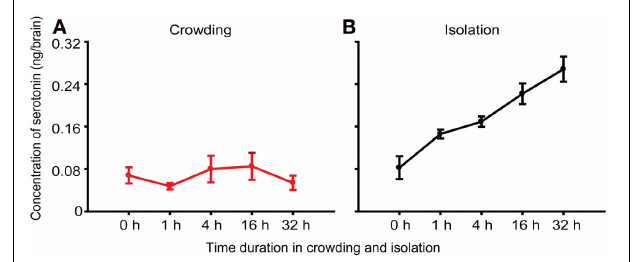
FIGURE 1 | Concentration of serotonin in brains of the migratory locust. (A) Concentration of serotonin in the brains of solitary nymphs subjected to crowding [One-way ANOVA, F ( 4 , 35 ) = 0 . 529, P = 0 . 753]. (B) Concentration of serotonin in the brains of gregarious nymphs subjected to isolation [One-way ANOVA, F ( 4 , 35 ) = 40 . 890, P < 0 . 001]. The data represent mean values and error bars represent SEM.